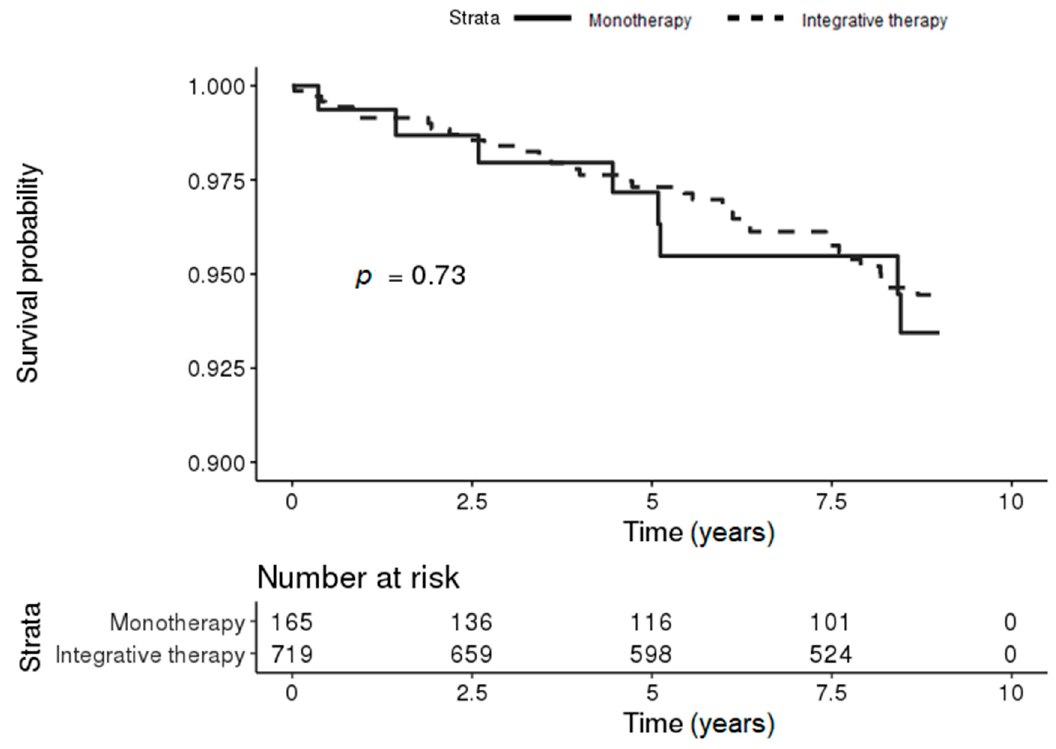
Figure 4. Kaplan–Meier survival curves for the incidence of PD in patients with IBD according